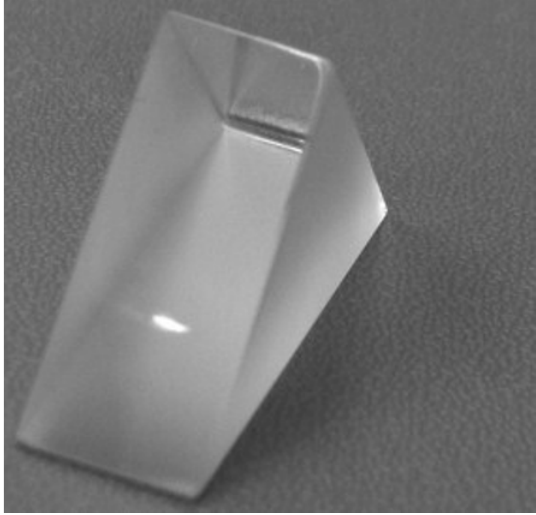
Fig. 9. Functional verification on a laser-polished prism.